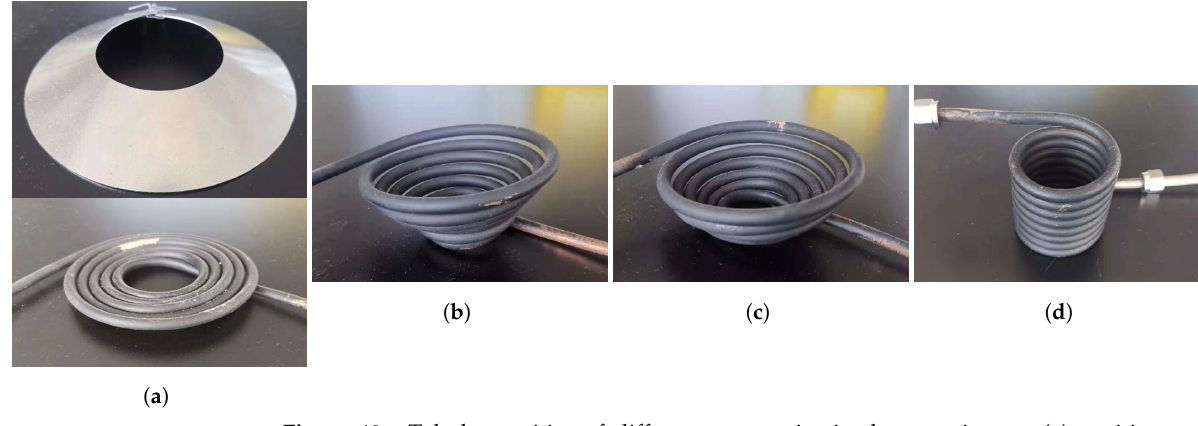
Figure 12. Tubular cavities of different geometries in the experiment: ( a ) positive conical ∗ ; ( b ) negative conical; ( c ) hemispherical; ( d ) cylindrical through. ∗ : This cavity is formed by two parts.